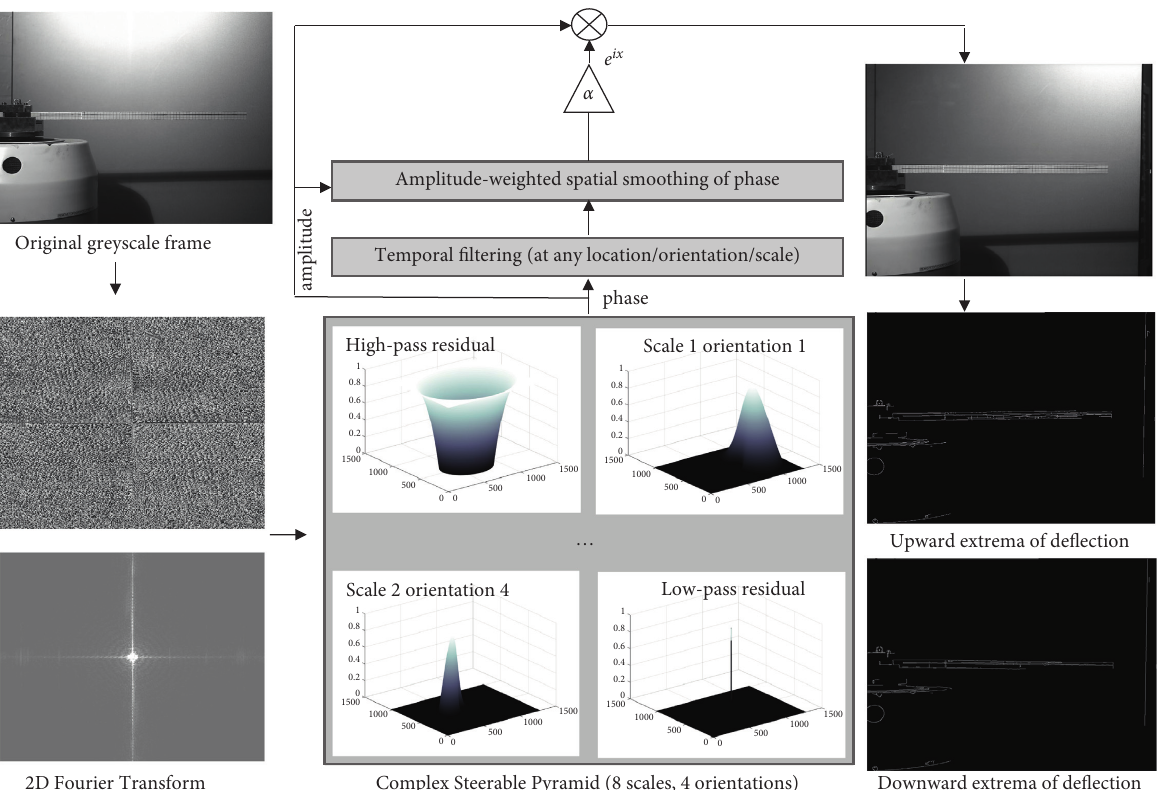
Figure 1: The conceptual scheme of the PBMM algorithm, plus the edge detection routine for the extraction of ODSs. The numerical modelling of the OTS.